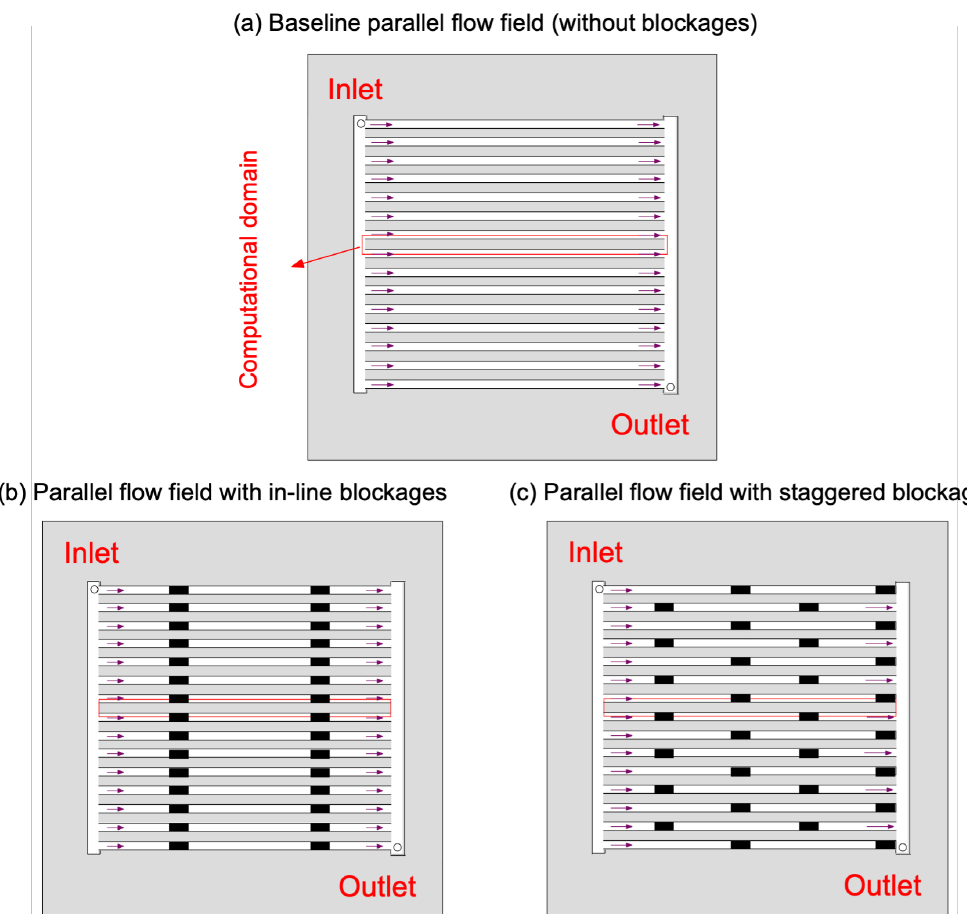
Figure 19. The schematic diagrams for the two novel flow fields at cathode of PEMFC investigated. The anode flow fields are conventional (parallel without blockages as shown in ( a )) [76].